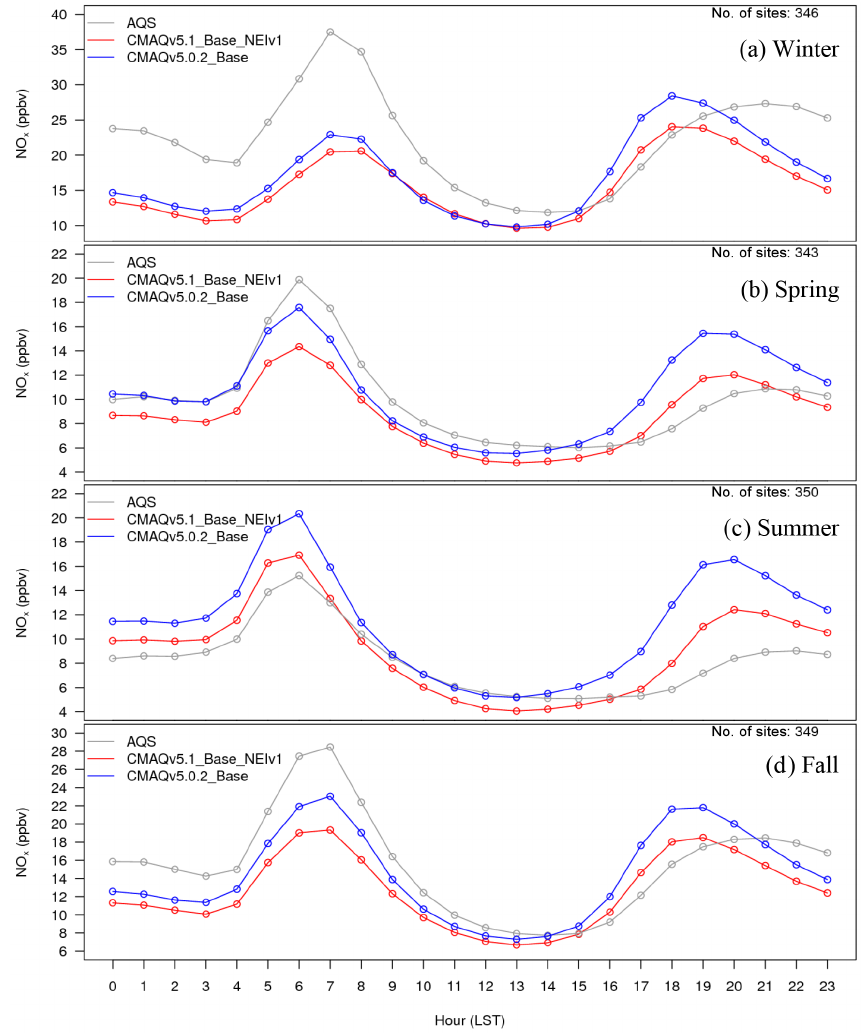
Figure 15. Diurnal time series of seasonal NO x (ppbv) for AQS observations (gray), CMAQv5.0.2_Base simulation (blue) and CMAQv5.1_Base_NEIv1 simulation (red) for (a) winter, (b) spring, (c) summer and (d)